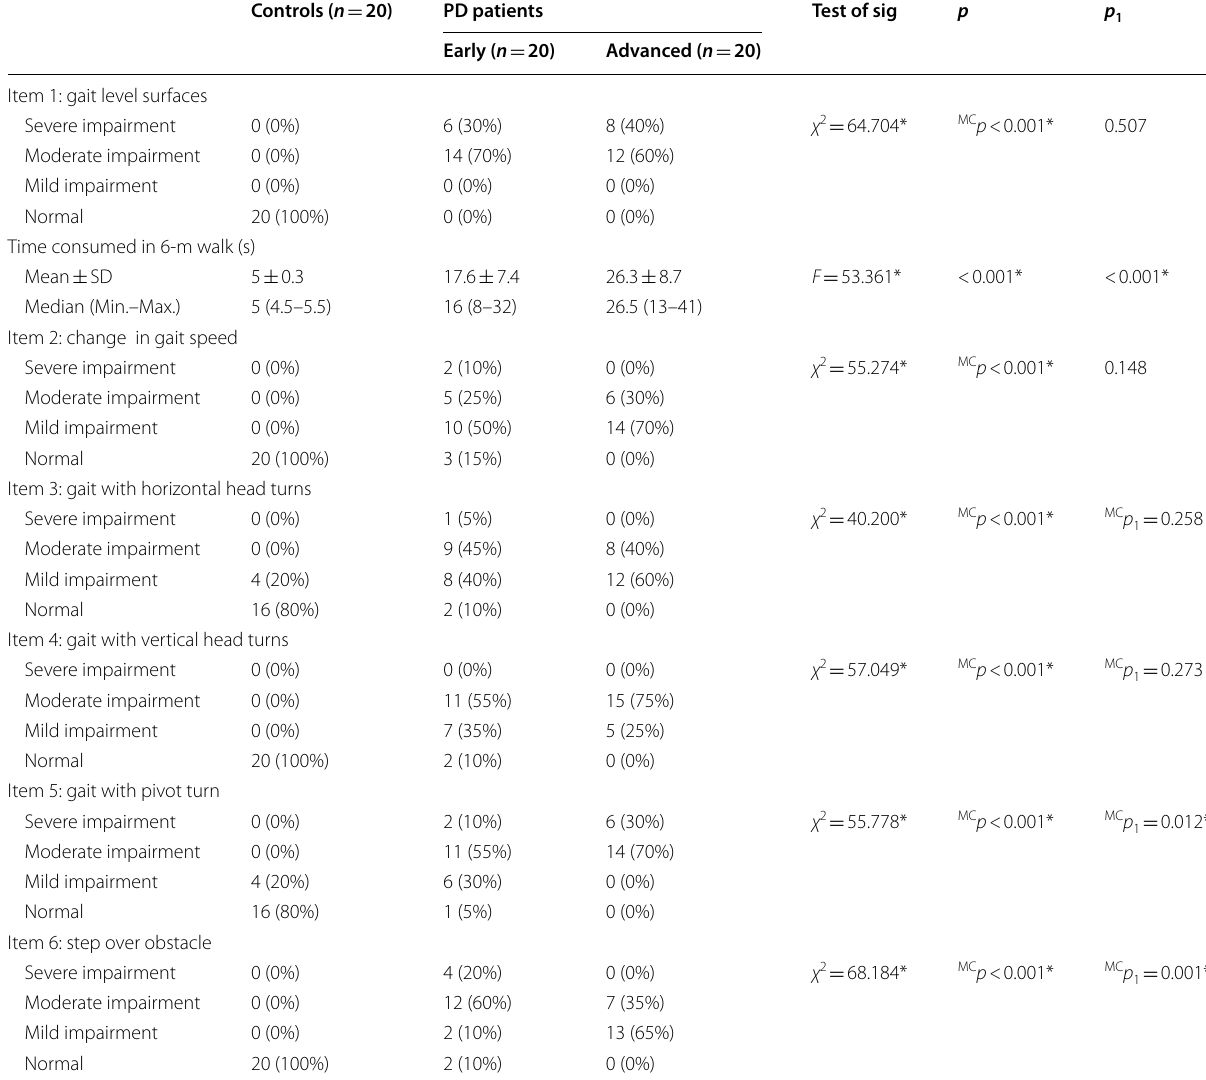
Table 3 Comparison between the studied groups according to functional gait